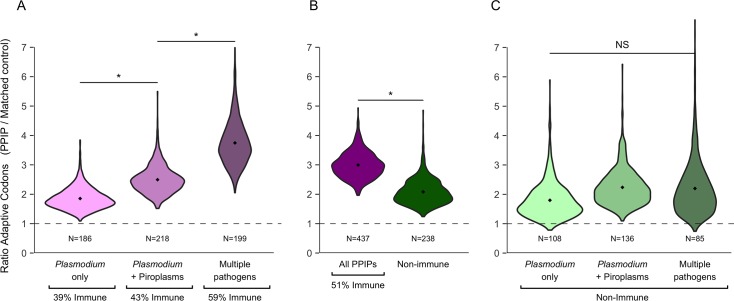
Pathogen pleiotropy is linked to adaptation for immune PPIPs.Each violin plot depicts a set of 1000 ratios comparing the mean proportion of adaptive codons in PPIPs to that in 1000 sets of matched controls. Adaptive codons per gene are an average across all branches. The dashed line indicates the null 1:1 expectation for PPIPs:matched controls. (a) PPIPs are divided into those that are only known to interact with Plasmodium, those that interact with Plasmodium and Piroplasms, and those that also interact with viruses and bacteria. The fraction of PPIPs with annotated immune functions increases with the number of interacting pathogens, as does the ratio of adaptive codons in PPIPs: matched controls. (b) All PPIPs compared to PPIPs without annotated immune functions. The ratio of adaptive codons in PPIPs:matched controls is significantly lower for PPIPs without immune functions than for all PPIPs. (c) Non-immune PPIPs are divided into those that are only known to interact with Plasmodium, those that interact with Plasmodium and Piroplasms, and those that also interact with viruses and bacteria. Unlike for all PPIPs (a), interaction with pathogens beyond Plasmodium is not significantly correlated with additional adaptation in non-immune PPIPs. In all panels, each violin is significantly above the 1:1 expectation of PPIPs:matched controls (all p≤0.02). Horizontal bars indicate differences between violins; * = p<0.05, NS = not significant.